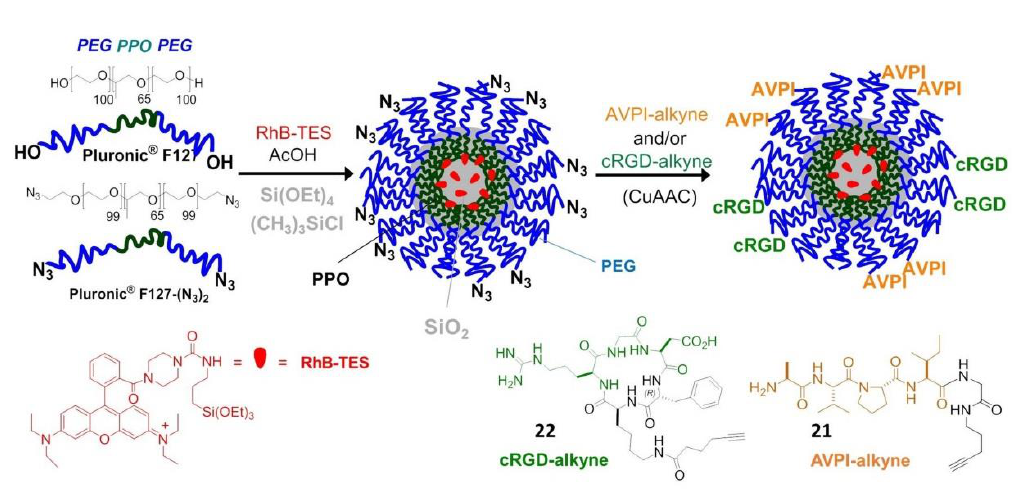
Figure 7. Preparation of AVPI/cRGD-NPs from micelles composed of PF127 (PEG 100 –PPO 65 –PEG 100 ) and PF127-(N 3 ) 2 , followed by polymerization of the silica core to embed the dye RhB. Peptide functionalization is achieved by click chemistry.